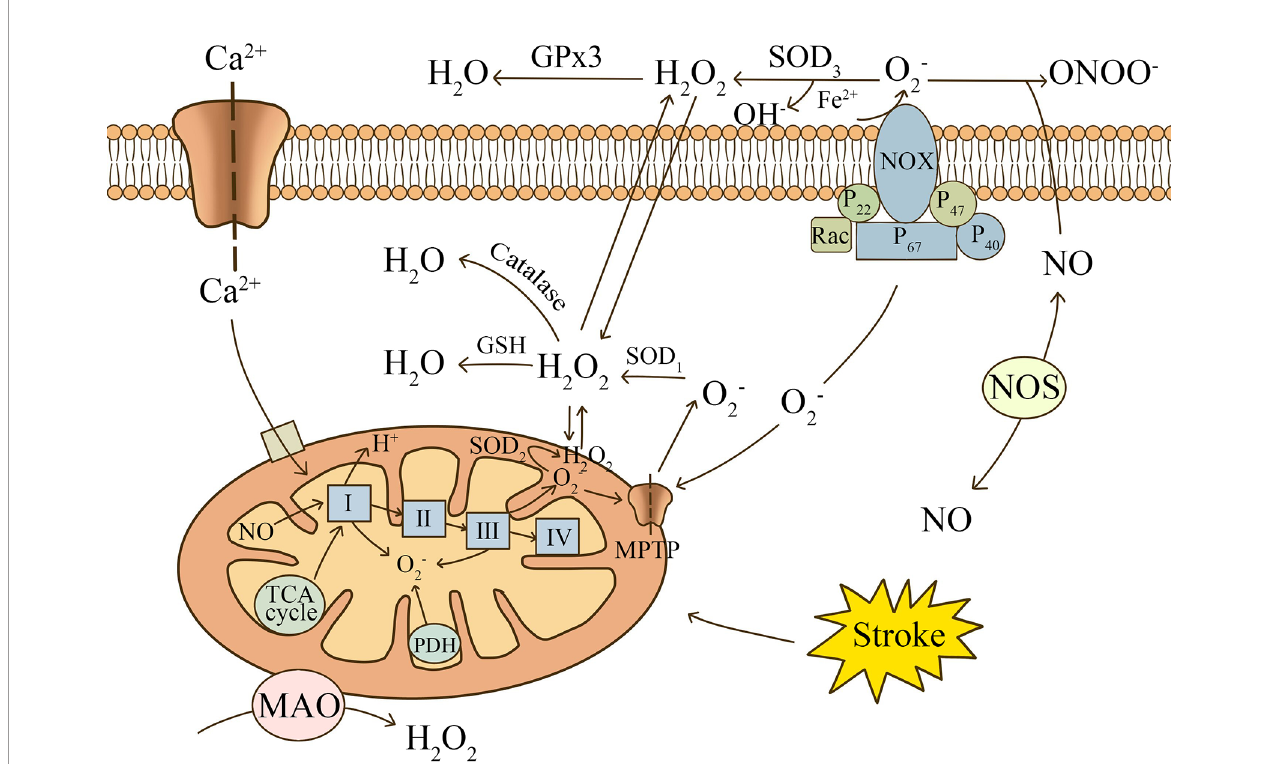
FIGURE 1 | The main mechanisms of ROS production after stroke. Electrons released from the electron transport chain (ETC) react with O 2 to produce superoxide. Mitochondrial complexes, oxidases in the matrix, and NADPH oxidase are involved in the release of ROS. Ca 2+ , NO, and succinate produced by the TCA cycle are important contributing factors. O − 2 is catalyzed by SOD to produce H 2 O 2 , which can be decomposed into H 2 O and O 2 . NO can combine with O − 2 to form ONOO - , causing nitrosative